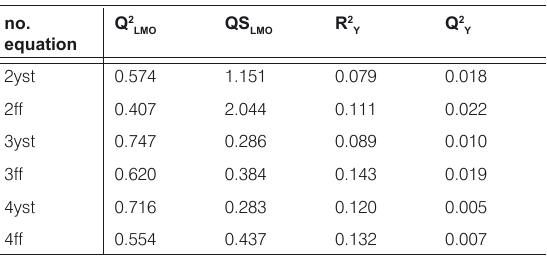
validation parameters: Q 2 – validated squared correlation coefficient, QS – prediction error sum of